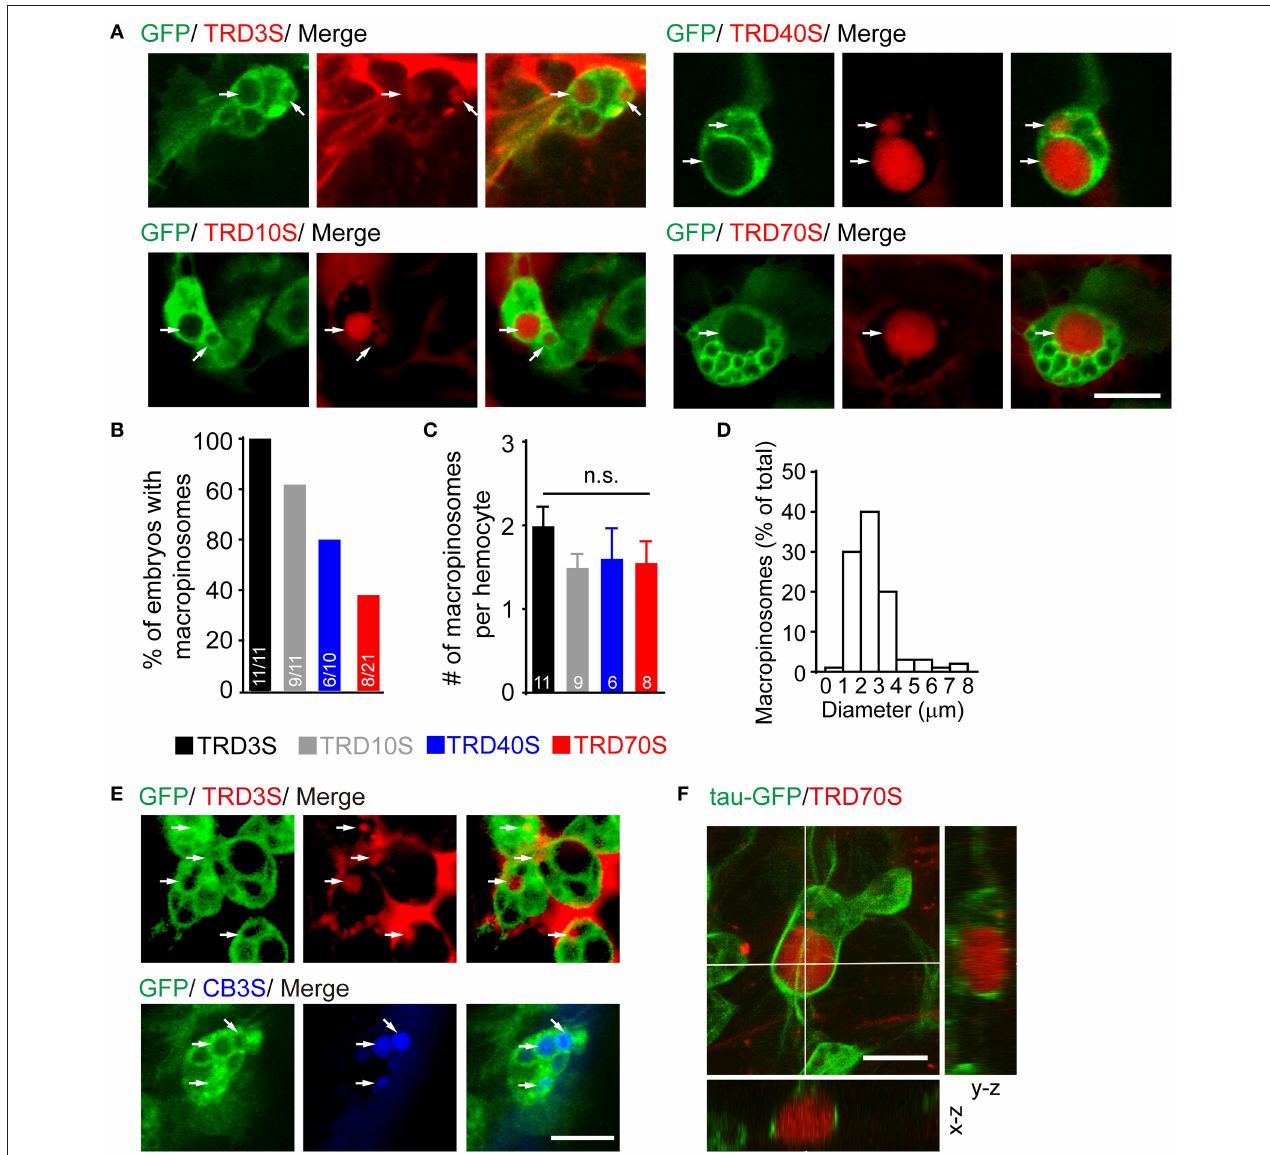
FIGURE 2 | ATP γ S induced macropinosomes in Drosophila embryonic hemocytes. (A) Hemocytes (green) uptook fluorescent dextrans ranged from 3-kDa (TRD3S) to 70-kDa (TRD70S) dextrans and generated macropinosomes (arrows). (B) Success rates were defined as the percentage of embryos where hemocytes with macropinosomes 1.5h after completion of different-sized dextrans injected. (C) Numbers (#) of macropinosomes in each hemocyte. P -values were calculated using one-way ANOVA among groups; n.s.: non-significant. (D) The size-distribution pattern of macropinosomes containing TRD3S ( n = 100 macropinosomes, from 11 embryos). (E) Both TRITC labeled (red, TRD3S) and cascade blue labeled (blue, CB3S) dextrans were feasible to be uptaken by GFP-positive hemocytes (green), and formed macropinosomes (arrows). (F) In-depth 3D reconstruction analysis of ATP γ S induced macropinosomes using a spatial deconvolution. Note that TRD70S dextran (red) labeled macropinosomes (red) and their surrounding GFP-positive microtubule-structures (green). Images were displayed in x-y (top), x-z (bottom), and y-z (right) projections. Scale bars, 10 µ m.